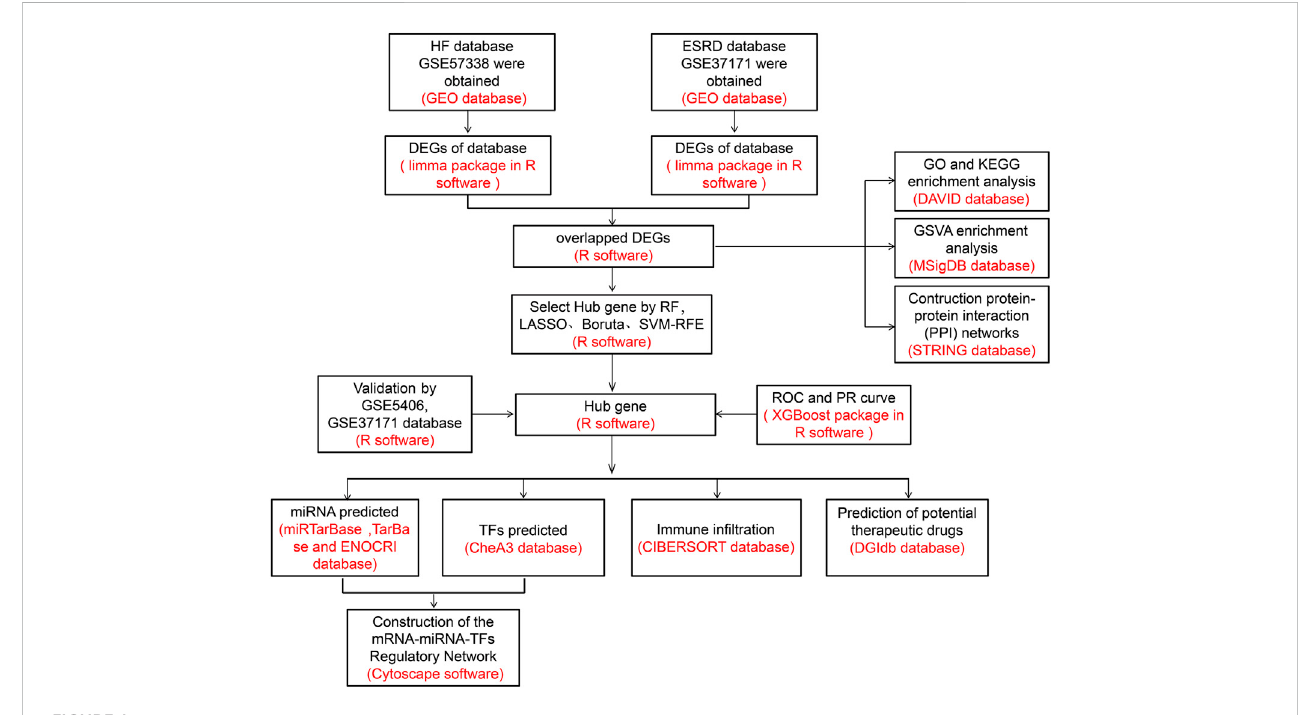
FIGURE 1 Study design of this